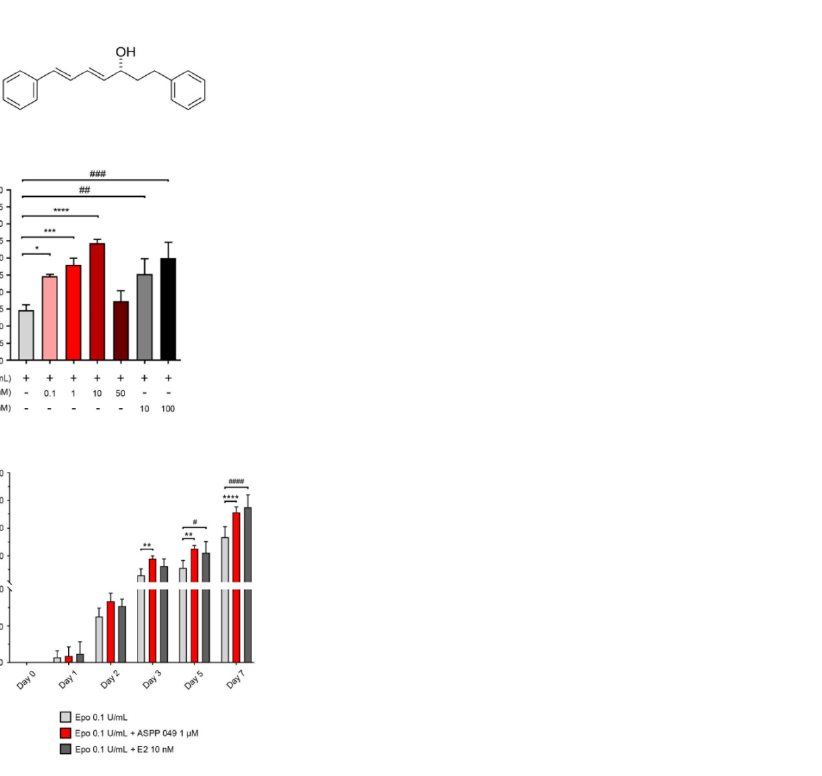
Figure 2. ASPP 049 ‐ and E2 ‐ induced murine erythroid progenitor cell formation. ( A ) Chemical structure of (3 R ) ‐ 1,7 ‐ diphenyl ‐ (4 E ,6 E ) ‐ 4,6 ‐ heptadien ‐ 3 ‐ ol (ASPP 049), a diarylheptanoid isolated from Curcuma comosa . ( B ) Concentration ‐ dependent induction of mouse erythroid cells by ASPP 049 and E2. Mouse Lin − bone marrow cells plated in MethoCult M3236 were treated with indicated concentrations of ASPP 049 or E2 in the presence of 0.05 U/mL Epo. At day 7, numbers of BFU ‐ Es were analyzed according to the manufacturer’s recommendations (Stem Cell Technologies). ( C ) ASPP 049 increased proliferation of mouse Lin − cells. Lin − cells derived from mouse bone marrow were treated with 0.1 U/mL Epo, 0.1 U/mL Epo + 1 μ M ASPP 049, or 0.1 U/mL Epo + 10 nM E2 for the indicated times. Proliferation of mouse Lin − cells was observed by trypan blue exclusion assay. All data are expressed as mean ± SEM ( n = 3). * p < 0.05 and ** p < 0.01, *** p < 0.001, **** p < 0.0001, ASPP 049 compared with vehicle control treatments (ANOVA); # p < 0.05, ## p < 0.01, ### p < 0.001, and #### p < 0.0001, E2 compared with vehicle treatments (ANOVA). BFU ‐ Es, burst ‐ forming unit ‐ erythroid cells; E2, 17 β‐ estradiol; Epo, erythropoietin; HSCs, hematopoietic stem cells; Lin − , lineage negative.